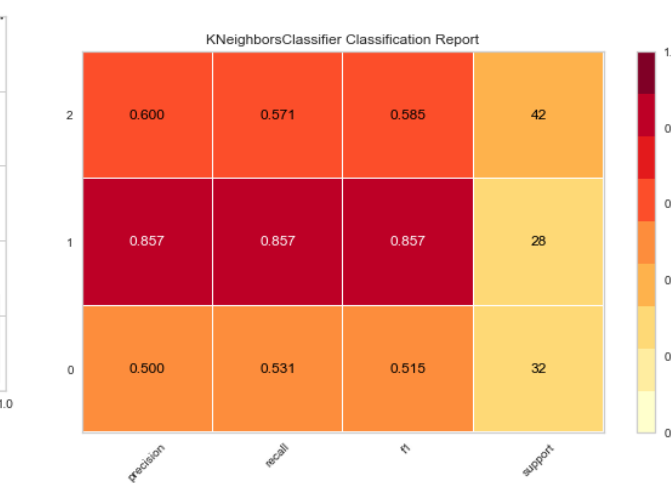
Fig. 11. Classification report for DT.